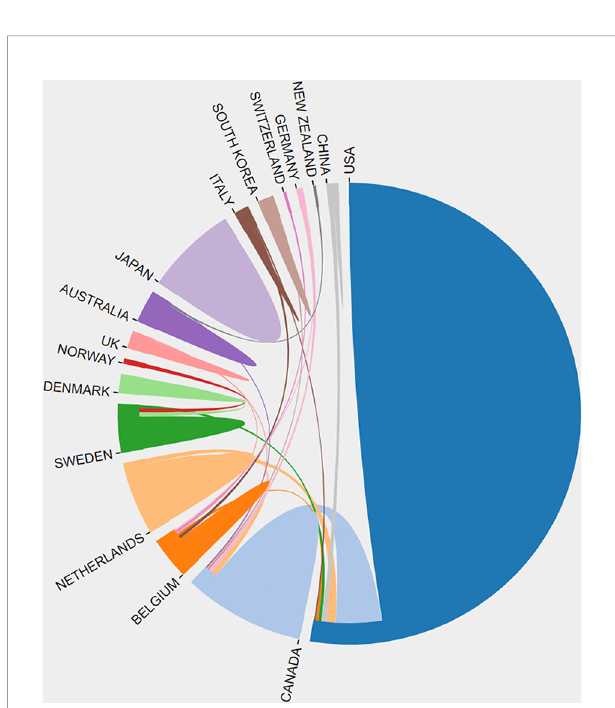
FIGURE 3 | Network visualization map for countries/regions collaboration.